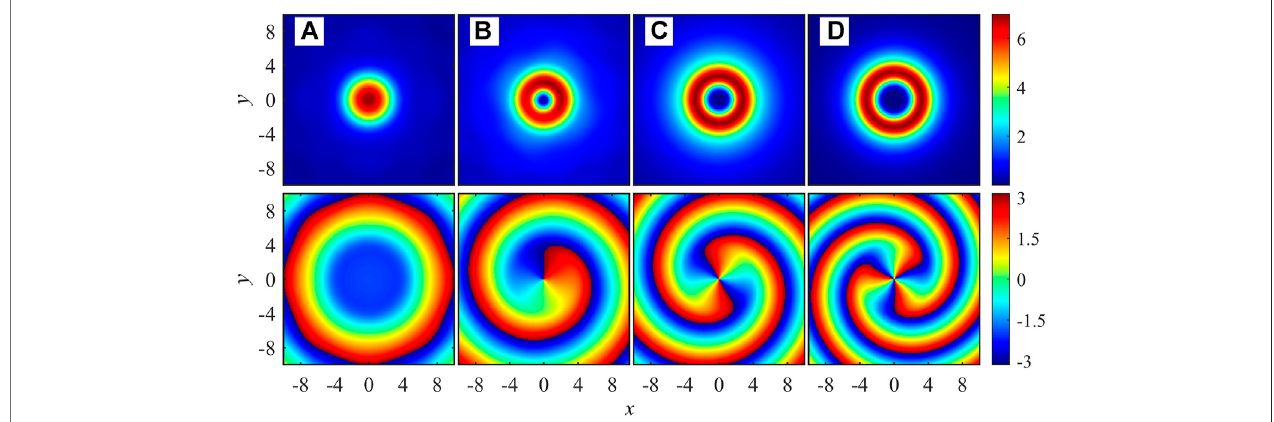
(cid:3)(cid:3)(cid:3)(cid:3) φ ( x , y )| 2 (upperpanels) andphase θ ( x , y ) (lowerpanels) describedby Eq.1 at t (cid:2) 400